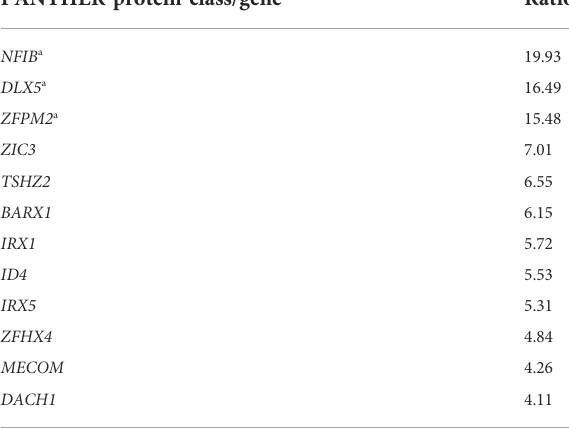
TABLE 2 Genes involved in the gene-speci fi c transcriptional regulatory protein group. PANTHER protein